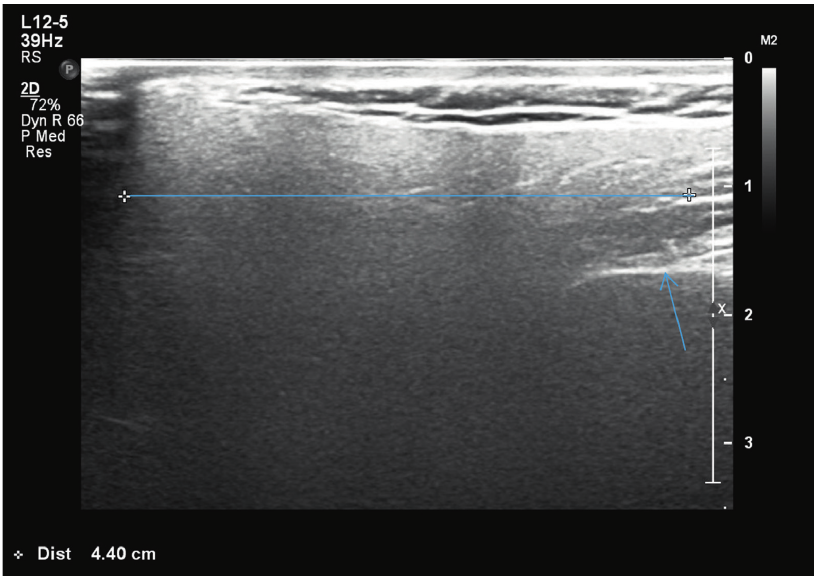
Figure 2: Right parotid gland measurement of transverse length of patient with HbA1c